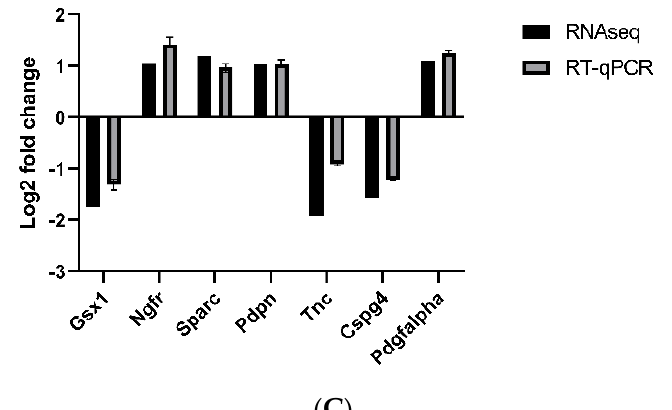
Figure 12. Comparison between RNA sequencing results and RT-qPCR between MMC and vehicle at ( A ) E15, ( B ) E17, and ( C ) E20.